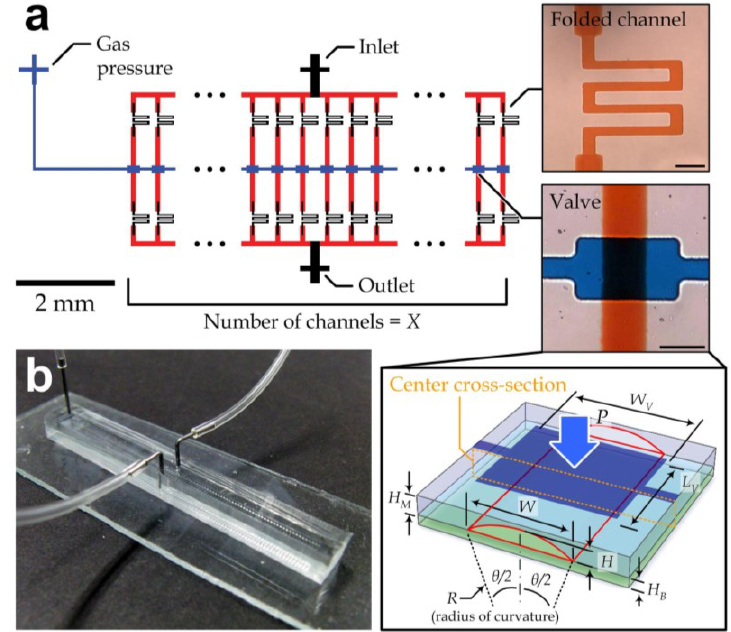
Figure 1. ( a ) Design layout of the microvalve devices. Upper-right insets: a folded flow channel structure and a region overlapping with flow channels and valve chambers. The channels/chambers were filled with color dyes for better visualization . Lower-right inset: Individual microvalve structure labeled with key configuration parameters. This structure only shows the two spin-coated polydimethylsiloxane (PDMS) layers, whereas the upper thick PDMS layer and the underneath glass slide are skipped. Scale bar in inset: 100 µm; ( b ) Fabricated microfluidic device containing 100